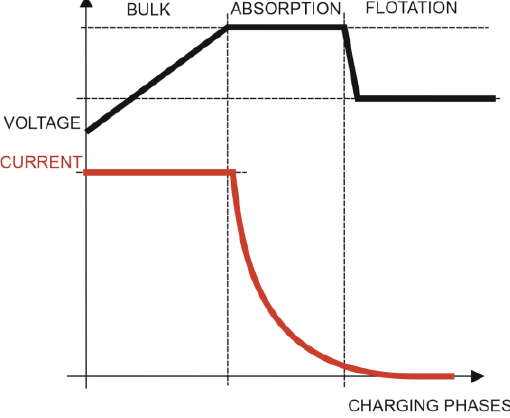
Figure 7. Batteries’ three-phase charge process.